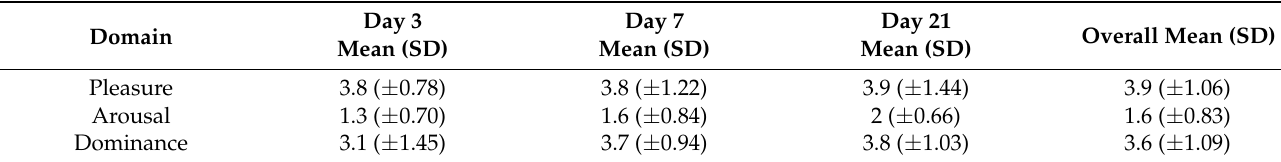
Table 2. Self-Assessment Manikin (SAM) results.